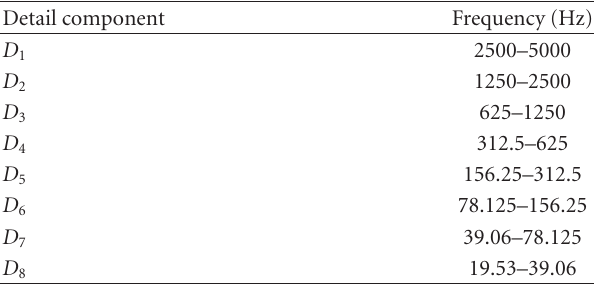
Table 1: Frequency ranges of detail